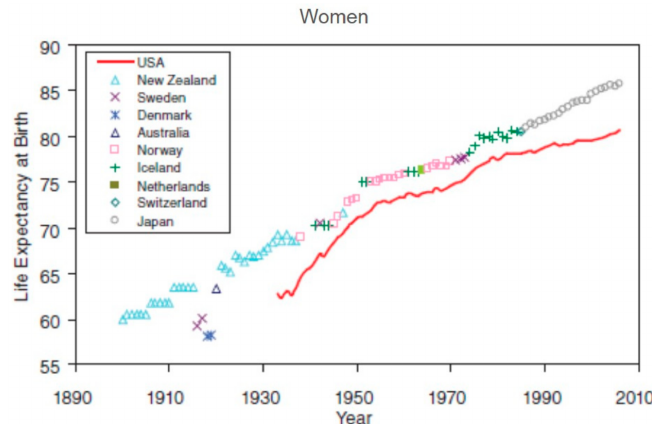
Figure 2. Life expectancy by country and year of origin for men (top) and women (bottom) since 1980 for different industrialized nations (represented by different symbols). U.S. is shown in red. (Reprinted from